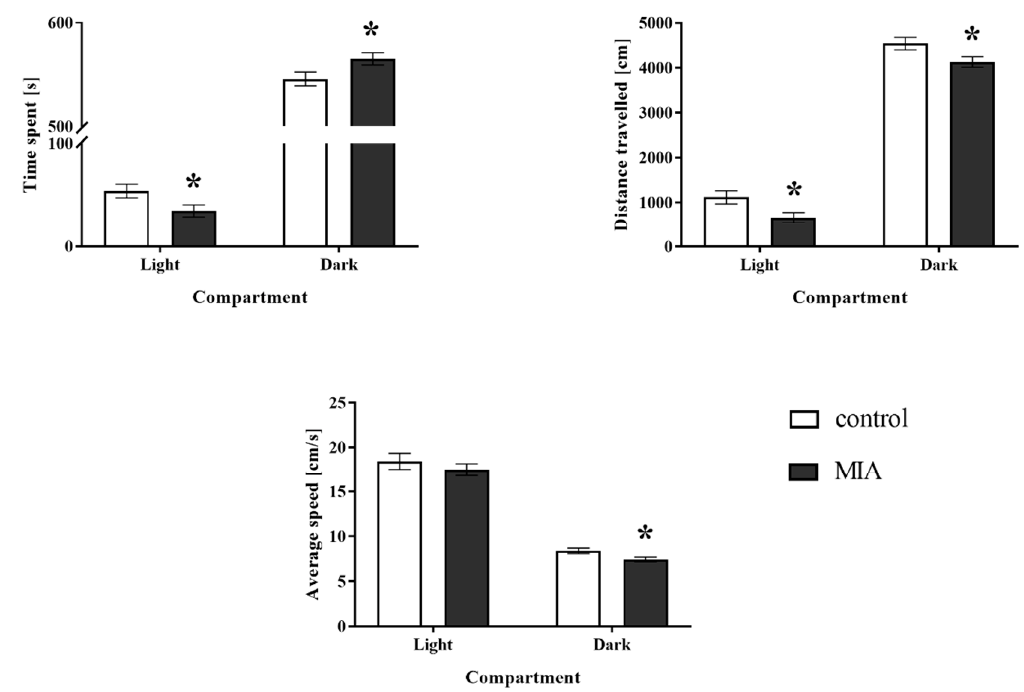
Figure 3. The effect of MIA on anxiety-like behaviours of adult male Sprague-Dawley offspring, measured in the light-dark box test. n = 42 in the control group, n = 69 in the MIA group. The results are presented as the means ± SEM. * p < 0.05 vs. control group.